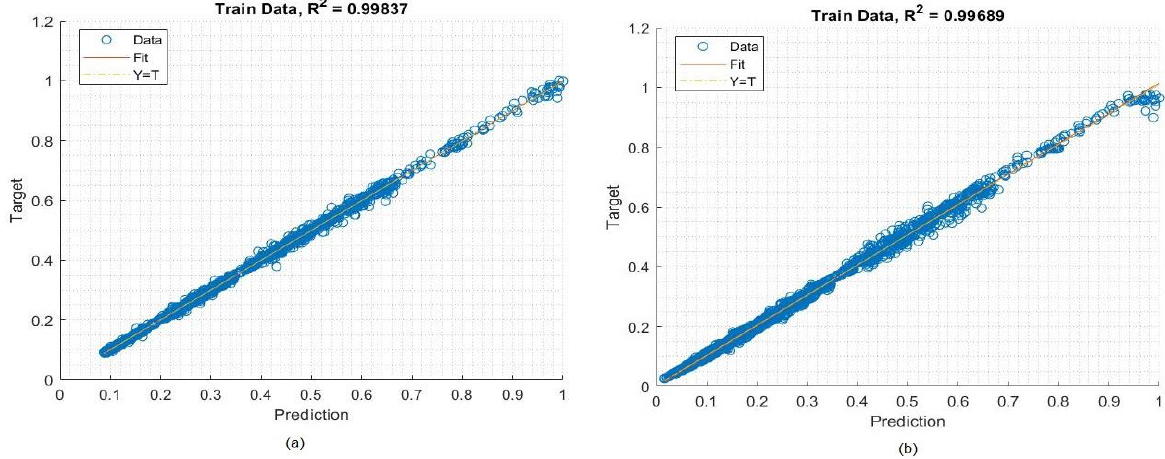
Figure 18. Squared regression plot of the deep learning models ( a ) CNN-LSTM and ( b ) LSTM during the training phase for Apple.